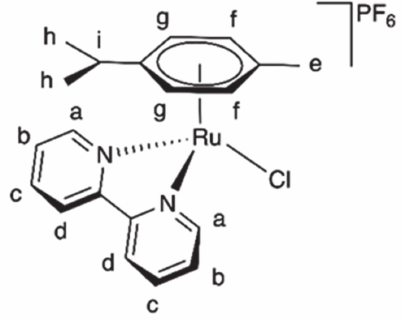
Figure 11. [( η 6-p-cym)Ru(N,N (cid:48) -bpy)Cl](PF 6 ) (IC3). 3.1.7. [( η 6 -p-cym)Ru(N,N (cid:48) -bpy)(N-4-formylpyridine-2-quinolinecarboxaldehydethio -carbohydrazone)](SO 3 CF 3 ) 2 (C) IC2 (0.10 g, 0.13 mmol) and L’ (0.03 g, 0.13 mmol) were dissolved in 20 mL of tetrahy- drofuran dry in a Schlenk flask in nitrogen atmosphere. The mixture was stirred for 24 h at room temperature covering the flask with aluminum foil to keep the solution in the dark. The mixture was then microfiltered on celite and the solvent of the clear solution obtained was removed under reduced pressure. Finally, the solid obtained was washed three times with diethyl ether and dried under vacuum. Orange solid. Yield: 82%. 1 H-NMR ( δ , ppm, 400 MHz, CD 6 CO): 0.84 (d, J = 6.9 Hz, 6H, H g ), 1.82 (s, 3H, H d ), 2.48 (m, 1H, H h ), 6.26